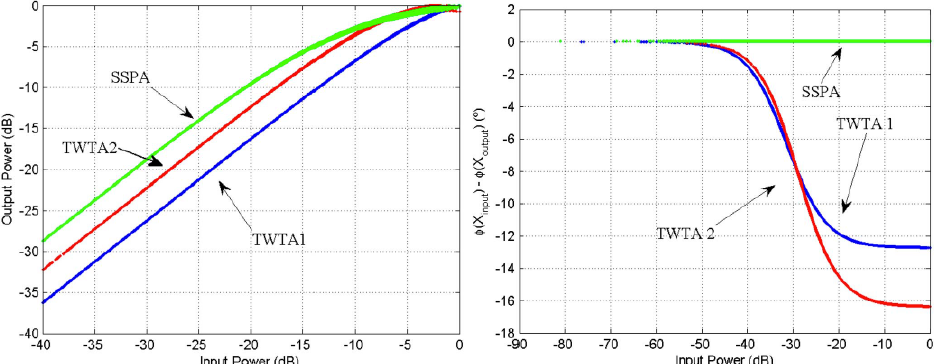
Figure 2. HPA non-linear response for amplitude ( left ) and phase ( right ). TWTA1: α || = 2, β || = 1, α PM = 4, β PM = 9, TWTA2: α || = 3, β || = 2, α PM = 2, β PM = 7, SSPA: NEC GaAs